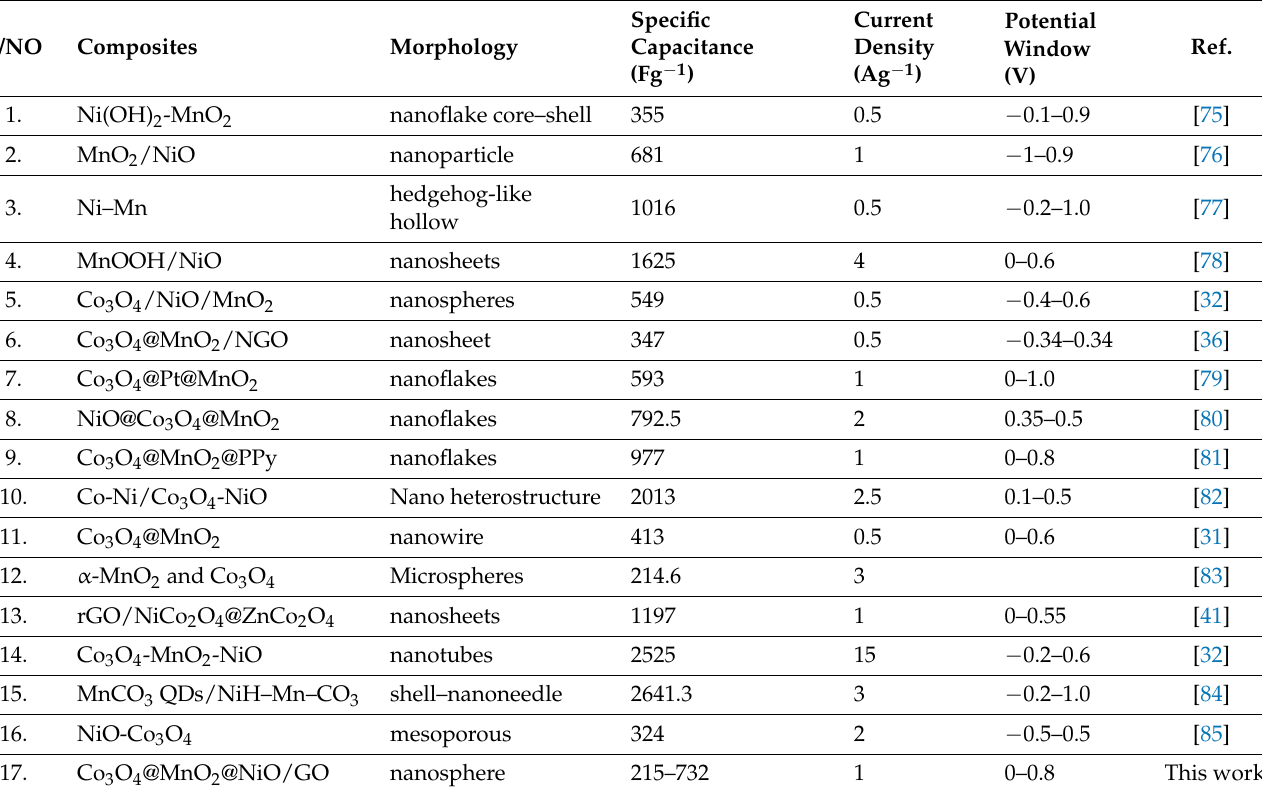
Figure 9. Plots of Specific capacitance versus scan rates of the electrodes with stability test as an inset. Table 4. Comparison of the supercapacitor values of various nanostructured cobalt oxides (Co 3 O 4 ),